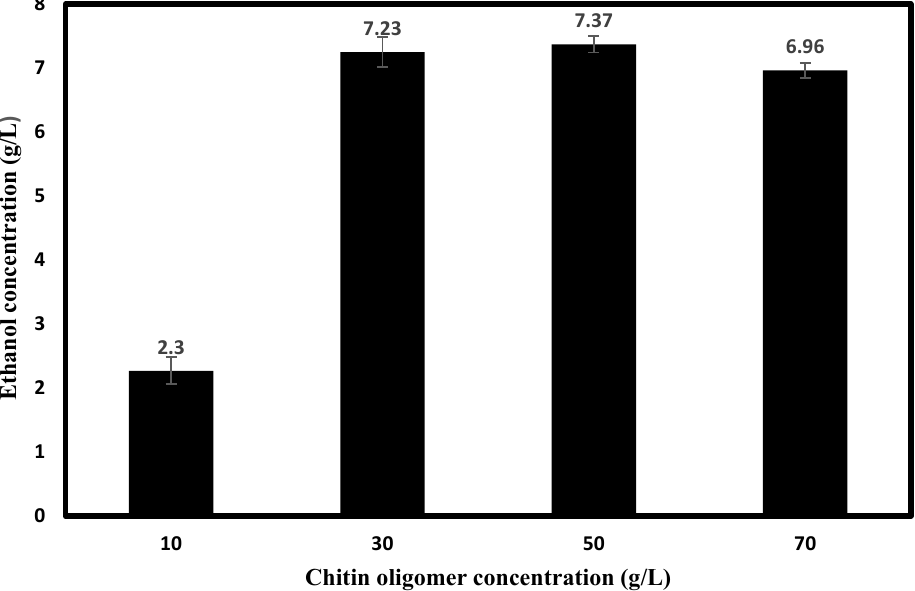
Figure 6. Effect of volume of fermentation medium on ethanol production from chitin oligomer by M. circinelloides. 3.4.3. Effect of Substrate Concentration on Ethanol Production In a fermentation process, substrate is a key material for nutrients, and its concentra- tion is important for making the process economical. With lesser substrate concentration, few substrates can bind to the enzyme’s active site, and an increase in substrate concen- tration can result in increase in product formation. Primarily, the concentration of sub- strate has an impact on uptake rates and product rate kinetics [44]. Production of a high concentration of bioethanol decreases the energy cost of distillation and hence influences economic efficiency [45]. However, high substrate concentration may result in a low titre